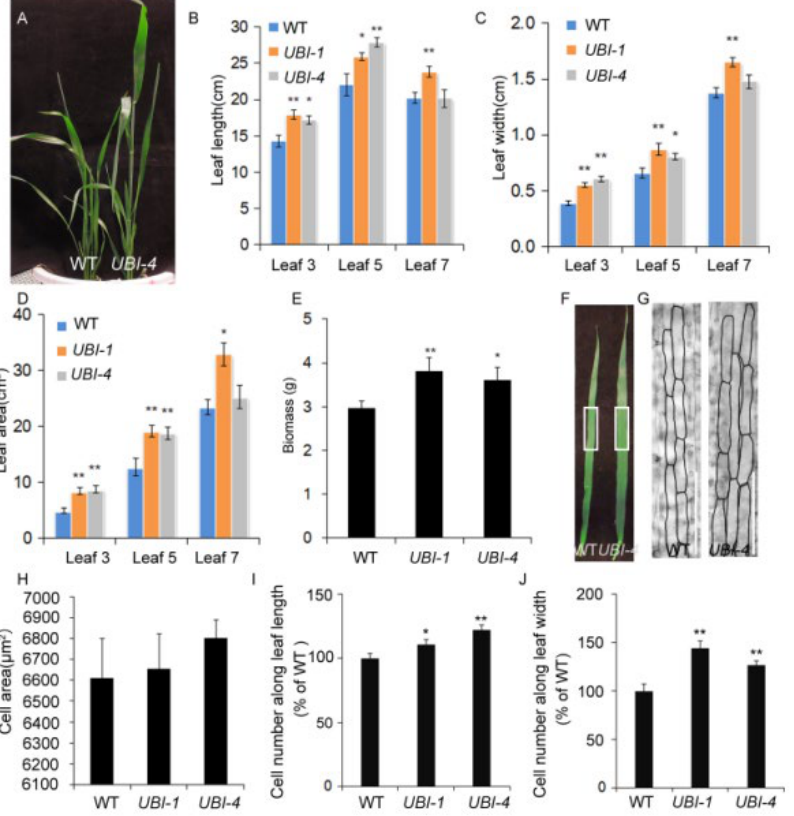
Figure 1. TaKLU regulated leaf size and biomass by affecting cell division in wheat. ( A ) WT (Wild type) and UBI::TaKLU transgenic wheat lines ( UBI-4 ) plants were shown at 80 days after sowing. ( B – D ) Statistics on the length ( B ), width ( C ) and area ( D ) of the leaves when they stopped elongating ( n > 7). ( E ) Statistical analysis of biomass in different genotypes wheat ( n > 16). ( F – J ) Cytological analysis of leaf 5 from WT and UBI::TaKLU plants in wheat. ( F ) Leaf 5 of the indicated genotypes at 16 days after its appearance. ( G ) Cell morphology characteristics in the middle of the leaf 5 in panel ( F ) (the position of white rectangle). ( H ) Statistics on the cell area ( n > 68) of leaf 5 at 16 days after its appearance. ( I – J ) Statistics on the cell number along leaf length and leaf width of leaf 5 at 16 days after its appearance ( n > 9). Bars indicate SE. Size bars represent 200 μm ( G ). Asterisks (*) and (**) indicate significant differences from their WT at p < 0.05 and p < 0.01 ( t -test),